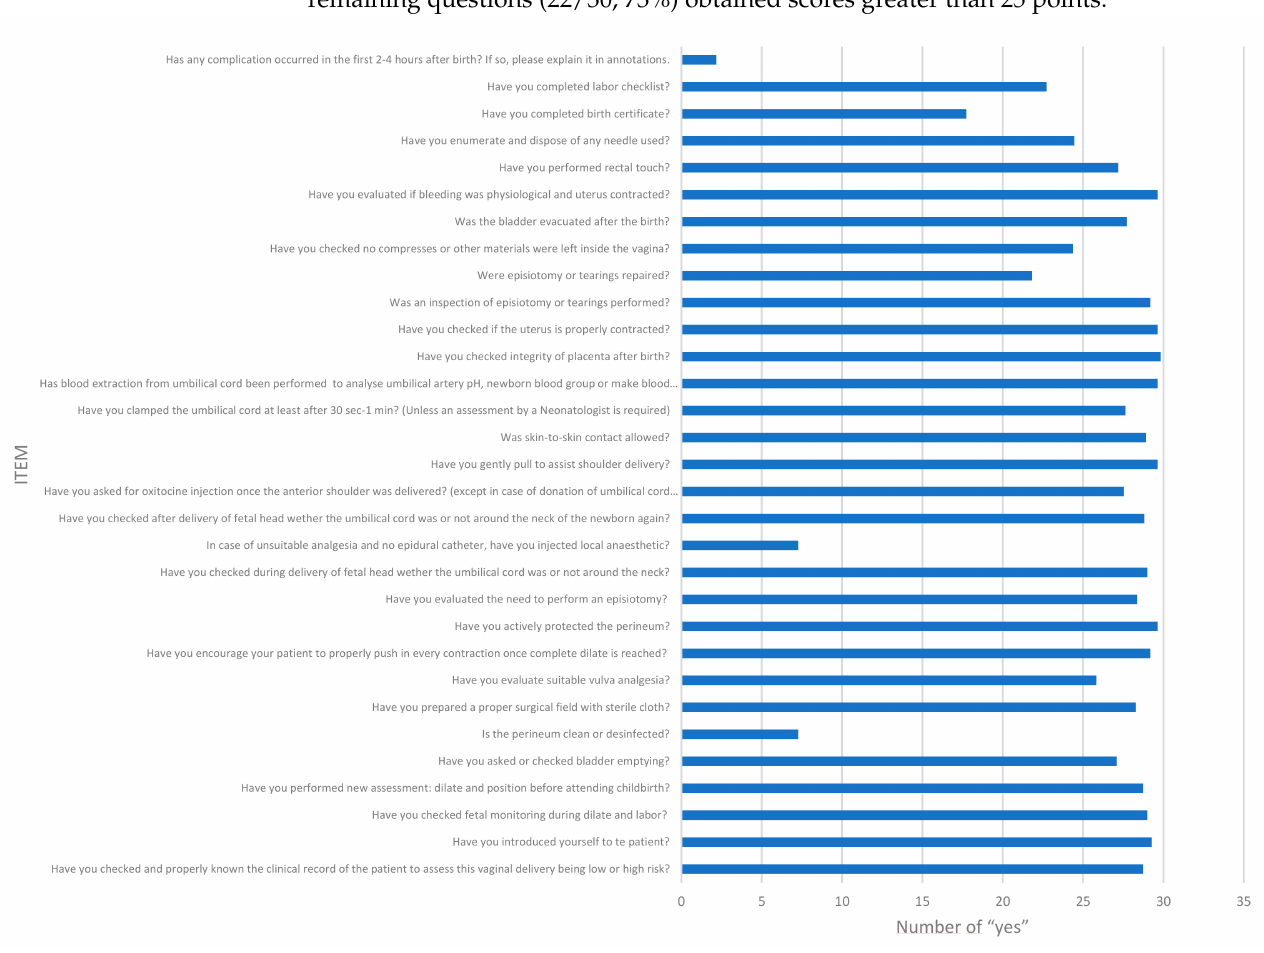
Figure 2. Mean number of positive responses completed on the CL for each